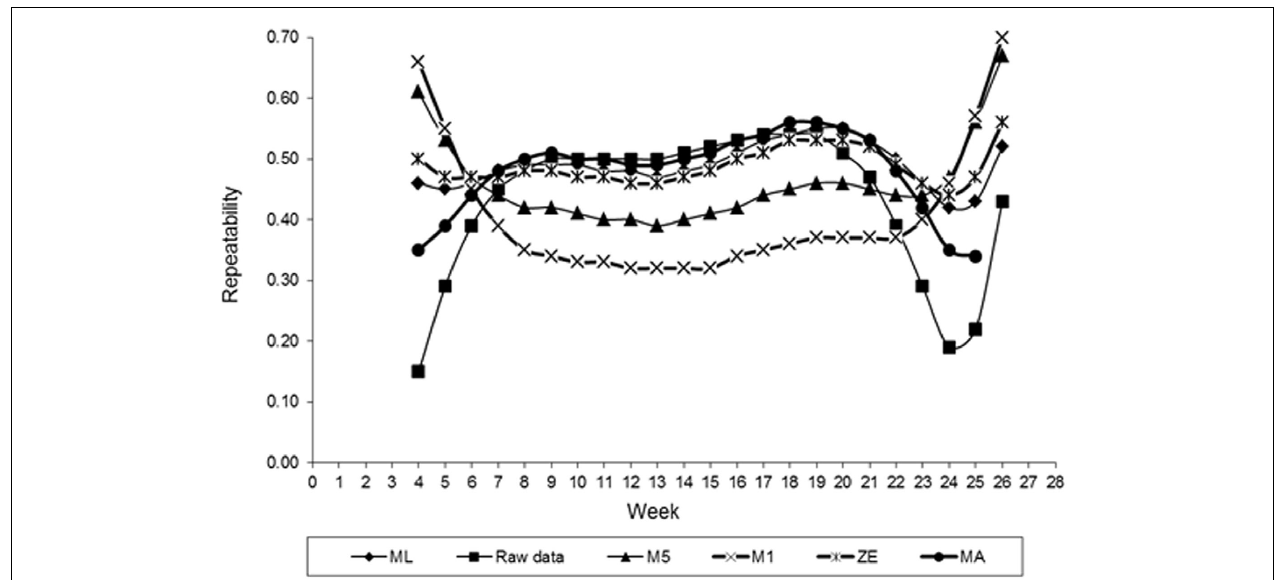
FIGURE 6 | Estimates of repeatability of fecal egg count (FEC) over time for different values of λ